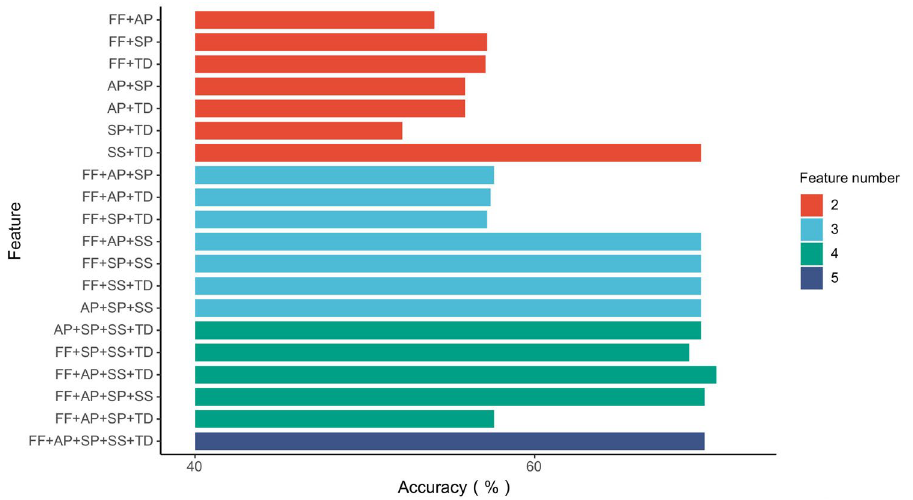
Figure 3. Accuracy of feature combinations by the Naive Bayesian